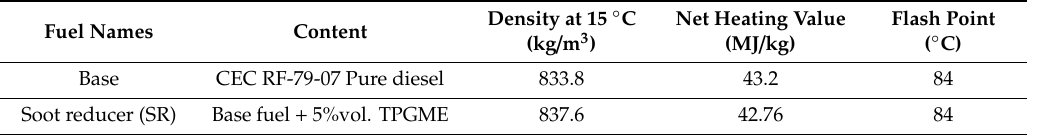
Table 3. Properties of the tested